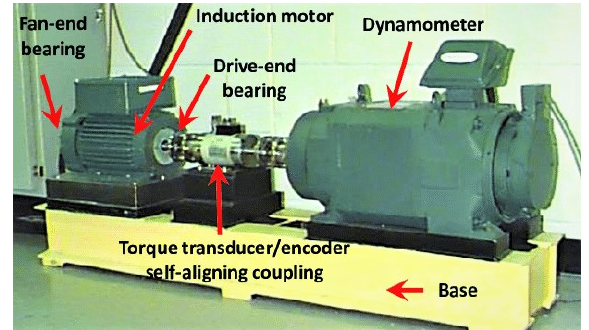
Figure 3. Bearing Test Rig